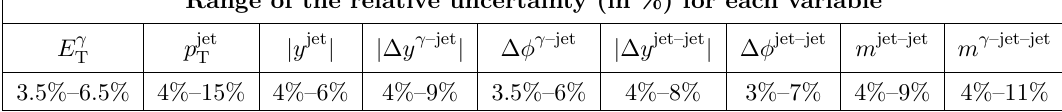
Table 2 . The total systematic uncertainty in the measured cross sections, excluding the uncertainty of the luminosity determination, for the total phase space: the range for each variable is shown in